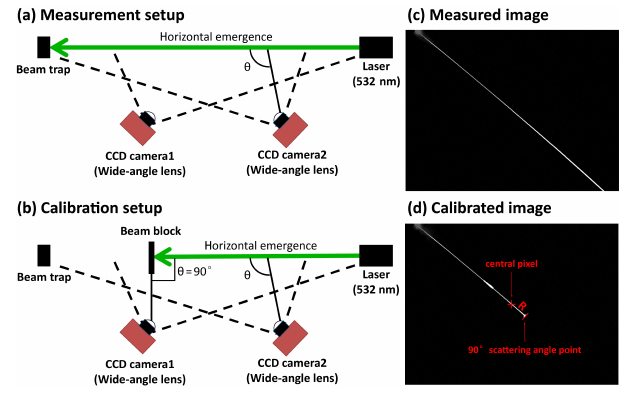
Figure 1. Sketch map of the geometric relationship and the sam- pling image of